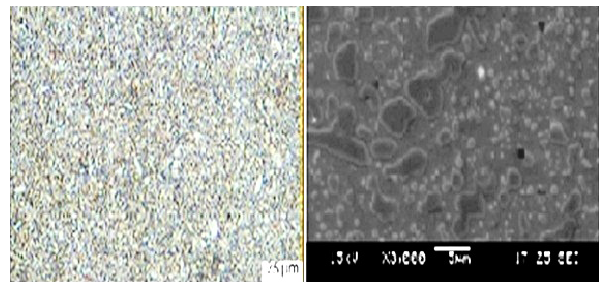
Figure 4. Cryogenically treated (CT) electrode microstructure.